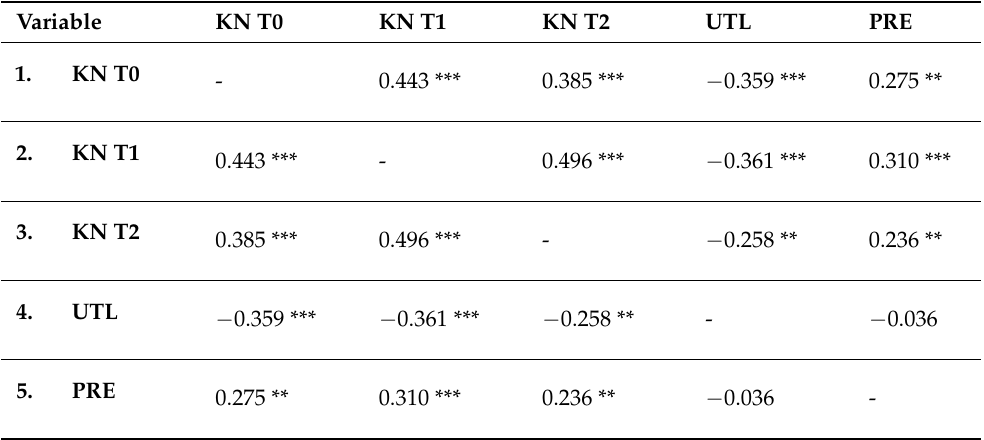
Table 3. Bivariate Spearman-rho correlations between the knowledge mean scores at all test times and the major environmental value (MEV) variables. p values: ** p ≤ 0.01, *** p ≤